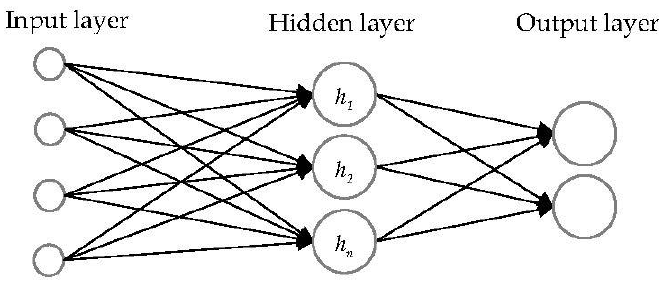
Figure 2. The architecture of the multilayer neural network.